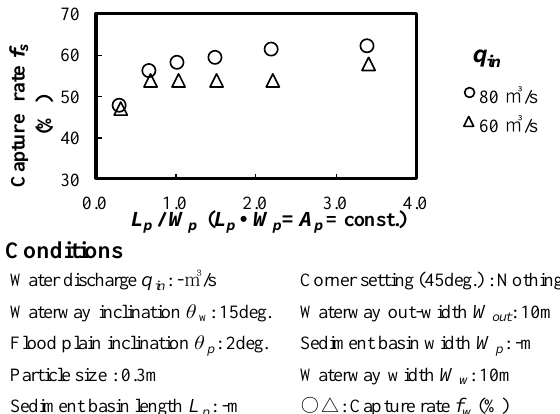
Figure 27. Effects of changes in the planar shape of the sediment retarding basin and the supply flow rate on sediment capture.